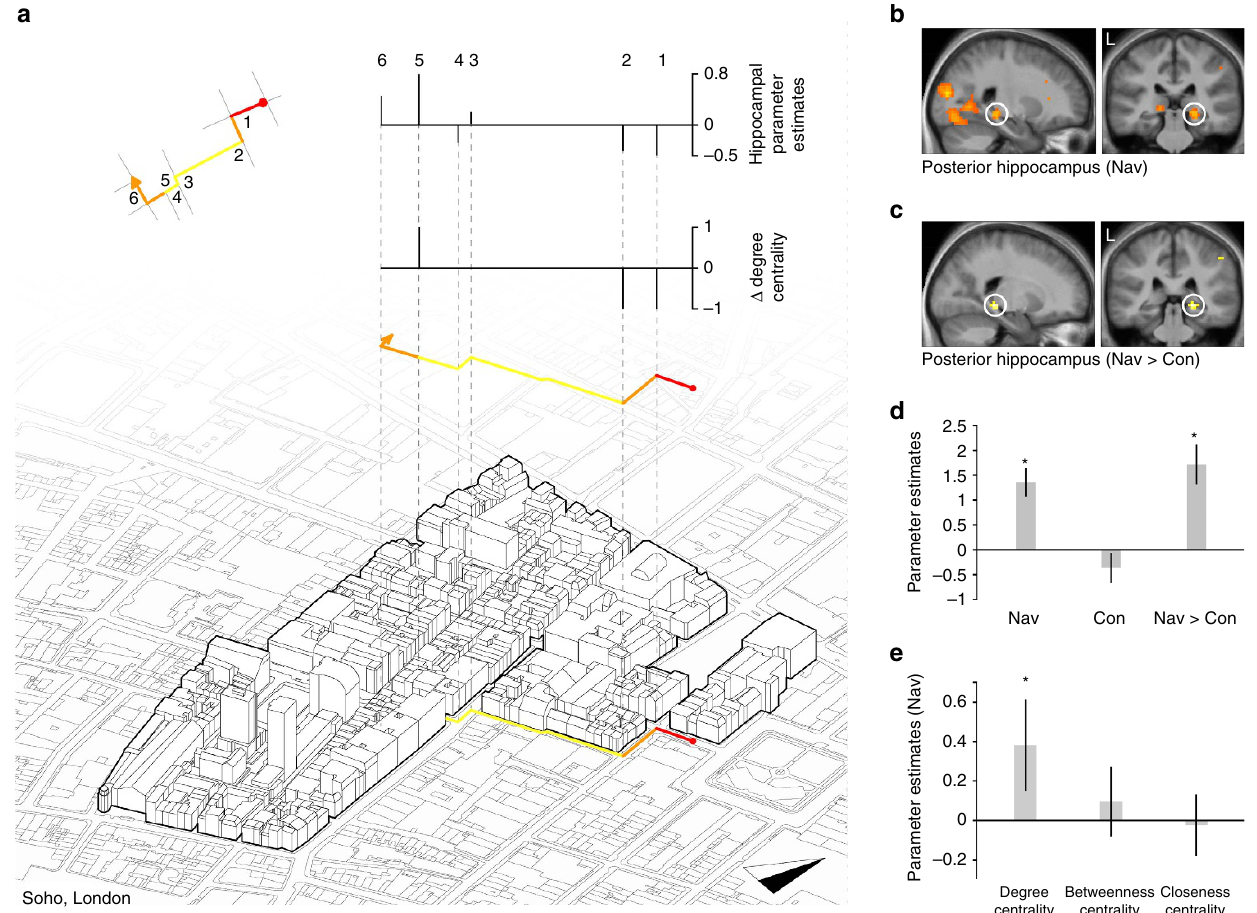
Figure 3 | Posterior hippocampal activity is correlated with the change in degree centrality during navigation. ( a ) Top left: degree centrality plotted for each street segment for an example route (see Fig. 2c). Right: axonometric projection of the buildings in Soho plotted on a map of Soho. Degree centrality of the route is plotted on the map and projected above. Above the route the graph plots the change in degree centrality for each boundary transition and the top graph plots the evoked response in the right posterior hippocampus at each of the individual boundary transitions (1–6). Analysis of this plot was not used for statistical inference (which was carried out within the statistical parametric mapping framework), but is shown to illustrate the analytic approach. ( b , c ) Right posterior hippocampal activity correlated significantly with the change in degree centrality for Navigation and Navigation 4 Control during Street Entry Events. Statistical parametric maps are displayed with threshold P o 0.005 uncorrected on the mean structural image. ( d ) Parameter estimates for the mean activity in the right posterior hippocampus ROI for Navigation ( t 23 ¼ 4.24, P ¼ 0.0003), Control ( t 23 ¼ 1.17, P ¼ 0.25) and Navigation 4 Control ( t 23 ¼ 4.64, P ¼ 0.0001) comparisons for a model containing categorical change in degree centrality (see Supplementary Table 2). ( e ) Parameter estimates for the mean activity in the right posterior hippocampus ROI for Navigation 4 Control condition for a model containing degree centrality ( t 23 ¼ 2.28, P ¼ 0.03), betweenness centrality ( t 23 ¼ 0.53, P ¼ 0.59) and closeness centrality ( t 23 ¼ 0.14, P ¼ 0.88) measures (Supplementary Table 3